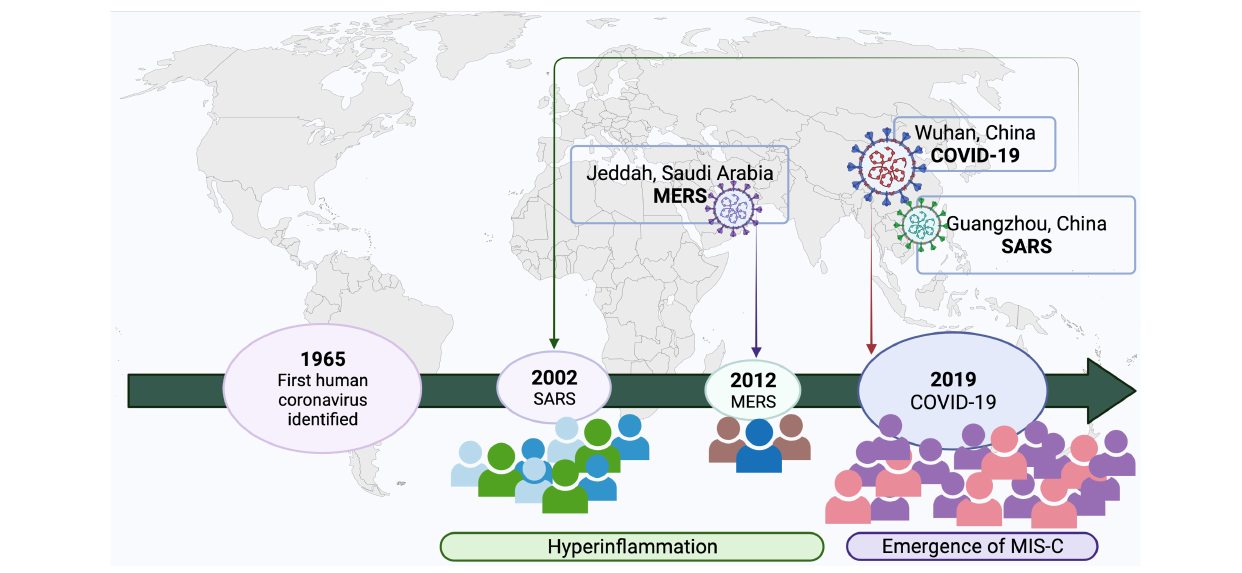
previous variants resulting in enhanced potency of